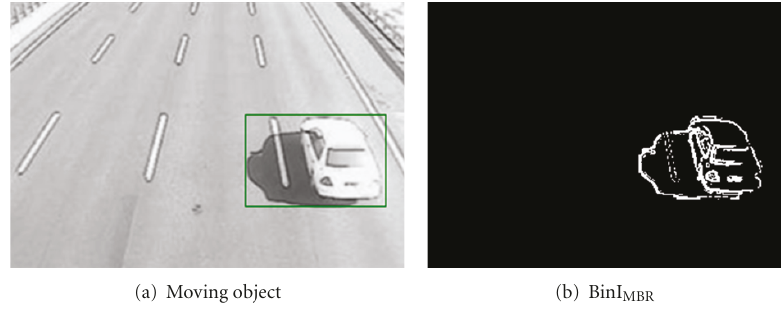
Figure 11: Homogeneous property of shadow, example